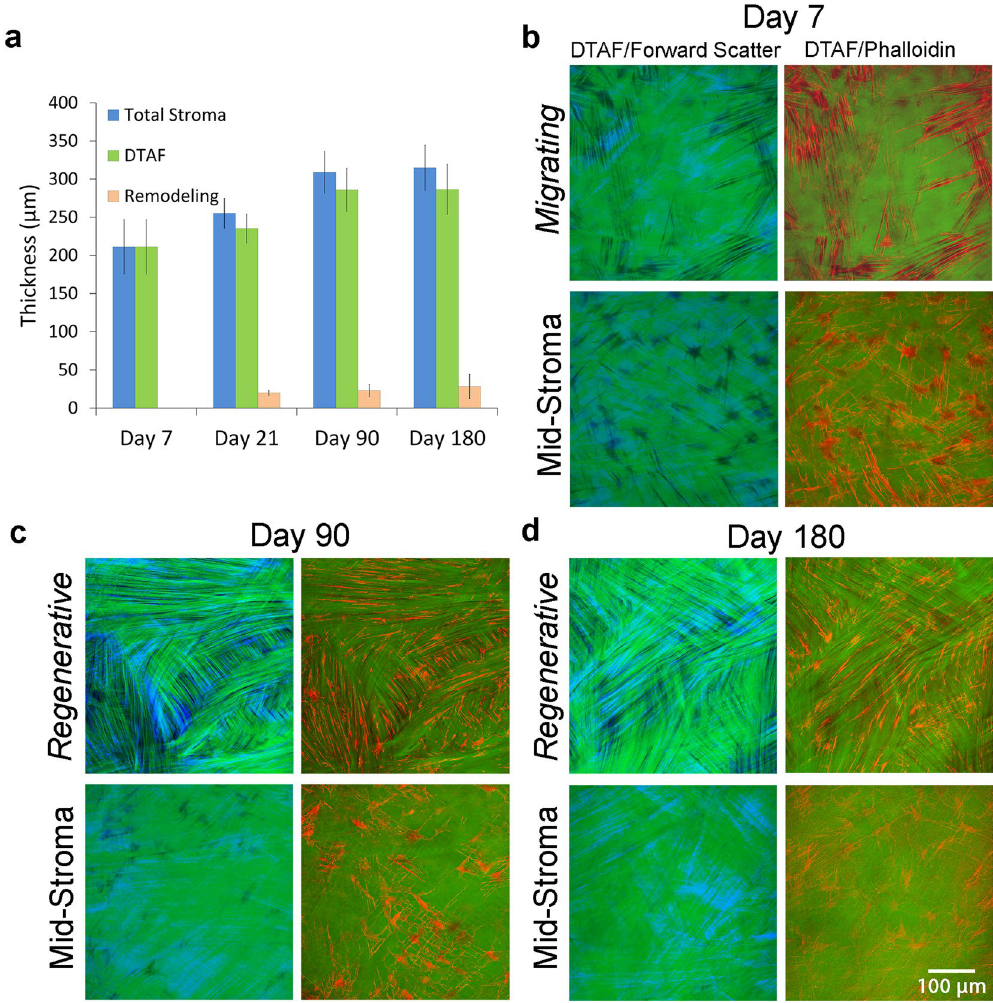
Figure 7. Patterning during regeneration of stromal tissue. ( a ) Measurements for remodeling region thickness, thickness of DTAF-labeled stromal tissue, and total stromal thickness over time. Overlays for DTAF (green), forward scatter (blue), and phalloidin (red) en face images at ( b ) 7 days, ( c ) 90 days, and ( d ) 180 days.